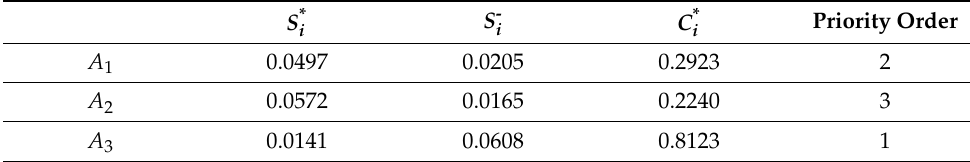
Table 8. The priority order of each